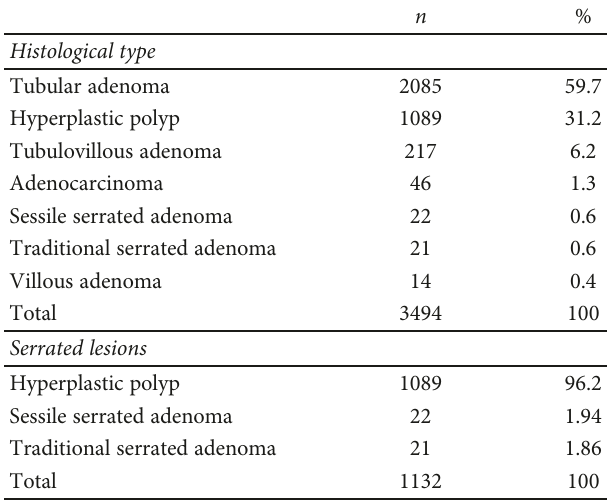
Table 1: Histological type, total number of each lesion (frequency), and percentage of the lesions found via colonoscopies along with distribution of all the histological types of only serrated lesions.